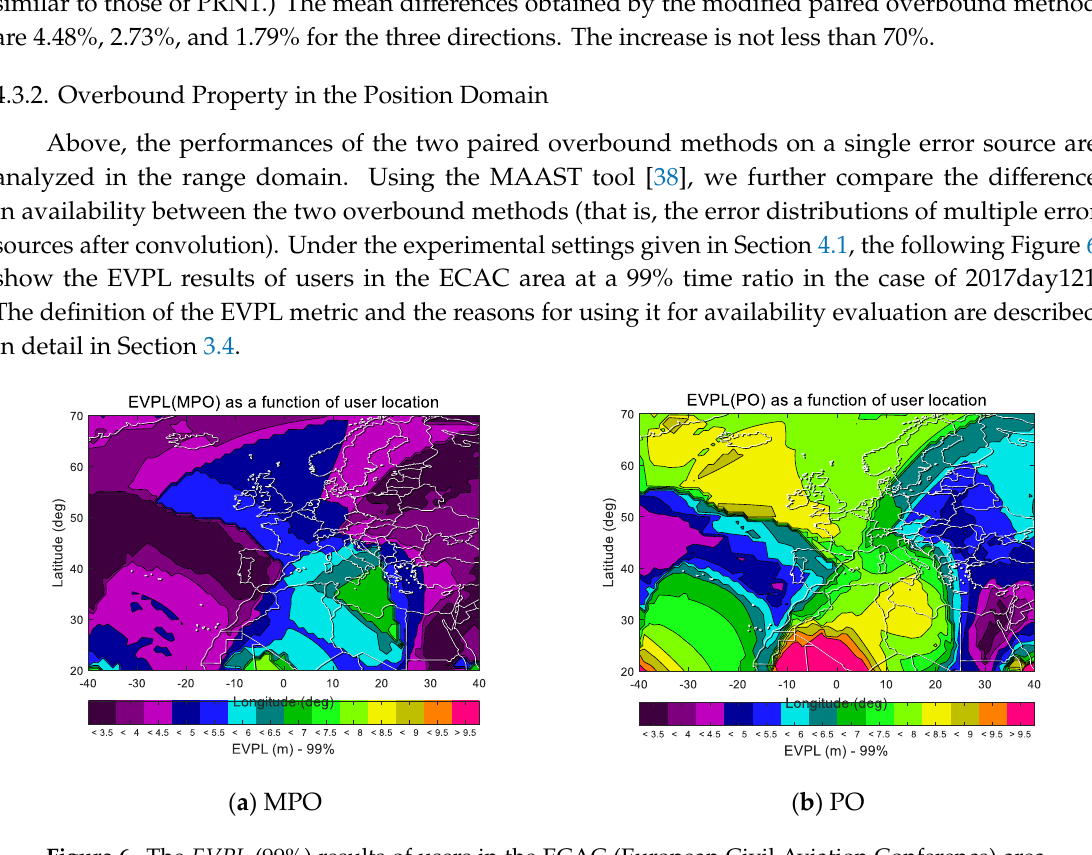
Figure 6. The EVPL (99%) results of users in the ECAC (European Civil Aviation Conference) area in the case of 2017day121: ( a ) the EVPL (99%) results of MPO method; ( b ) the EVPL (99%) results of PO method